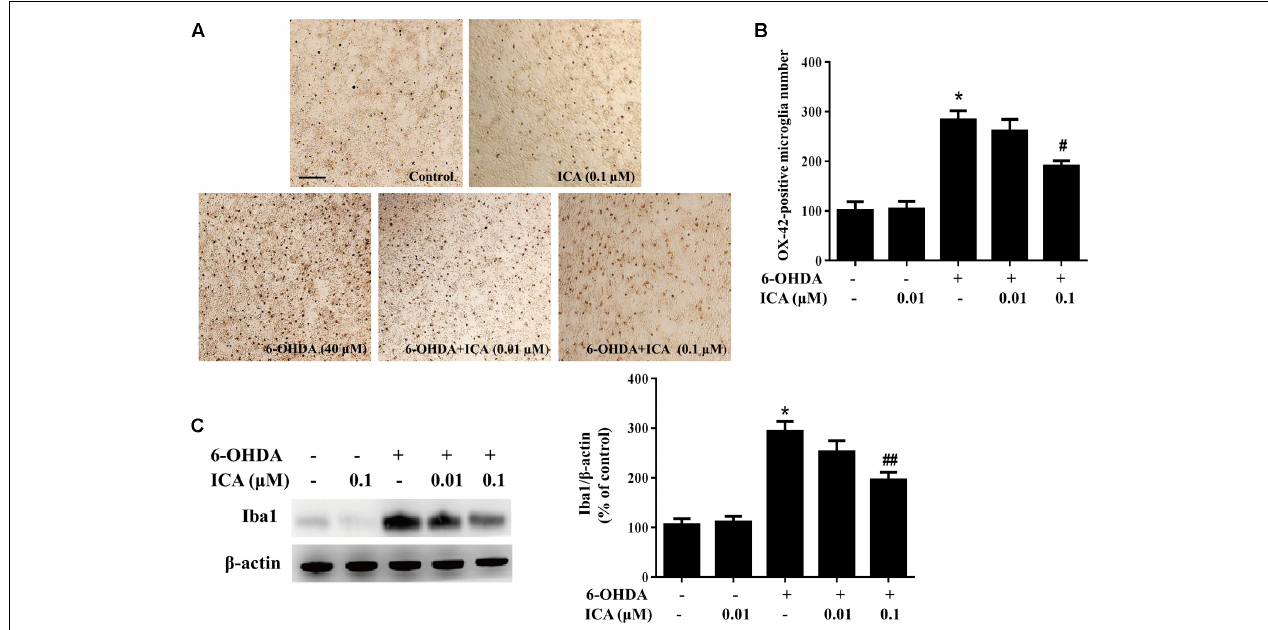
FIGURE 4 | Icariin attenuated 6-OHDA-induced microglial activation in vitro . Primary neuron-glia cultures were treated with ICA (0.01 and 0.1 µ M) for 30 min followed by 6-OHDA (40 µ M) treatment. Seven days later, the activated microglia were analyzed by immunocytochemical staining with an anti-OX-42 antibody. Representative images of immunostaining from three individual experiments were indicated (A) . Scale bar: 100 µ m. The number of OX-42-positive microglia was counted (B) . The level of Iba1 protein expression in the neuron-glia cultures was quantified by western blot analysis (C) . The ratio of densitometry values of Iba1 with β -actin was assessed and normalized to each respective control group. Results were the mean ± SEM from three independent experiments performed in triplicate. ∗ p < 0.05 compared with the control cultures; # p < 0.05 or ## p < 0.01 compared with 6-OHDA-treated